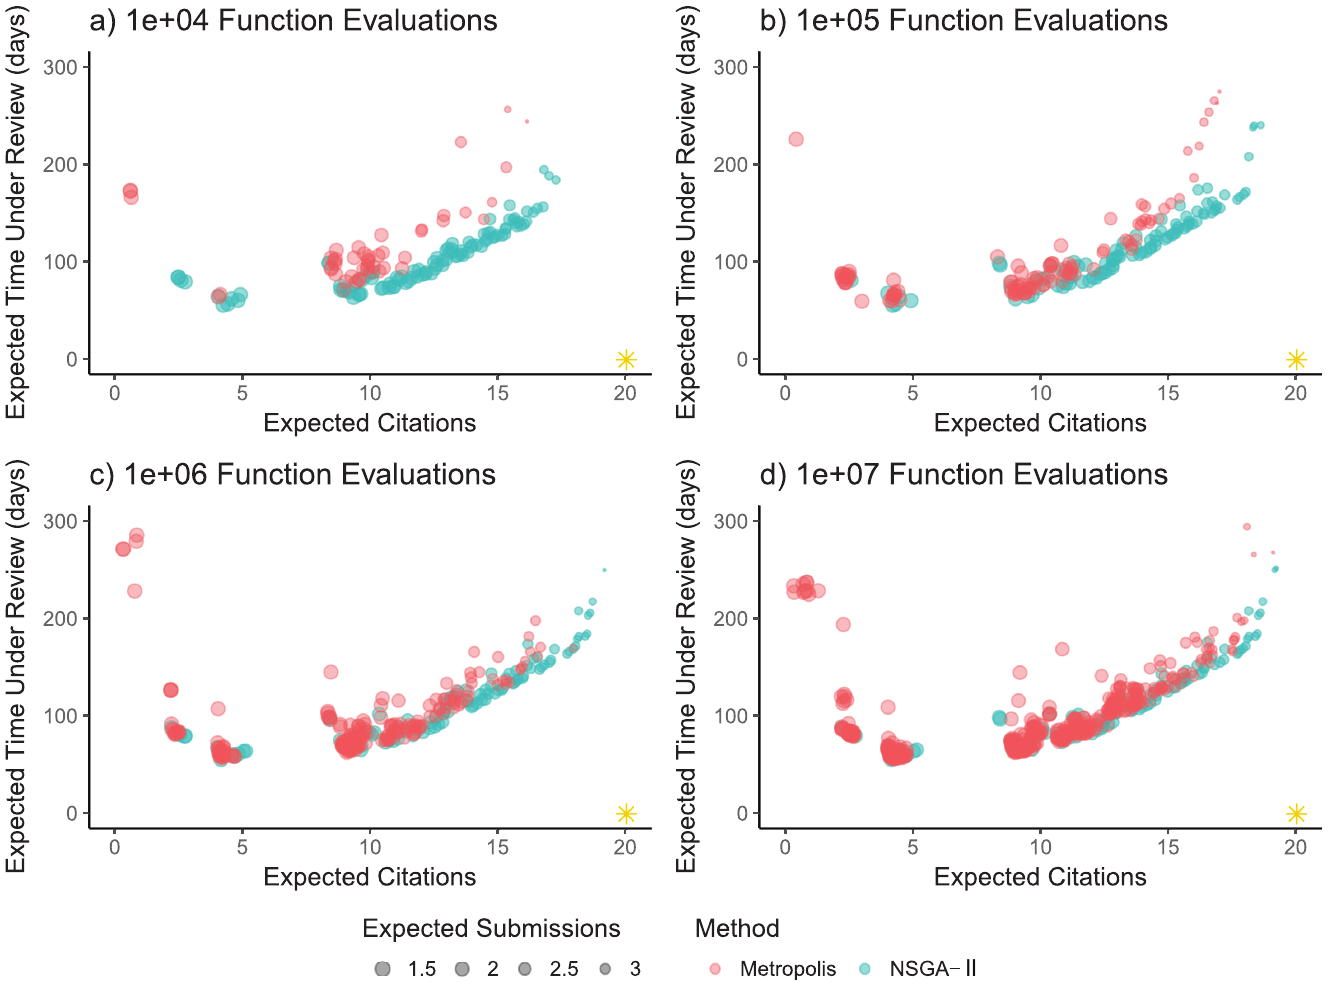
Fig 2. Performance comparison. The approximate Pareto front betweenexpectedcitations (horizontal axis), expectedtime under review (vertical axis) and expected number of submissions (size of points), as discoveredby the Metropolis algorithm(red points) or NSGA-II MOEA (blue points) for (a) 10 4 , (b) 10 5 , (c) 10 6 and (d) 10 7 function evaluations. The model was run with T = 3 years, s = 0.001 and t R = 30 days. The gold star in the lower-rightcorner represents the target directionfor the represented objectives.